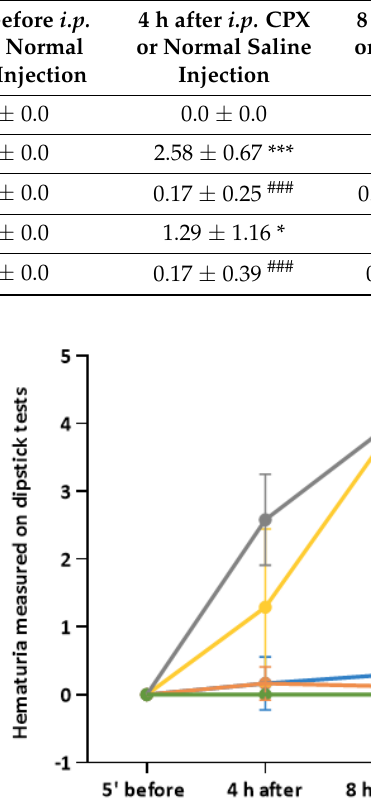
Figure 3. Hematuria measured semi-quantitatively on the dipstick test 5 min before, 4 h, 8 h, 24 h, and 48 h after injection of CPX in the studied groups or normal saline in the control group. Hematuria was evaluated from 0 to 4+ (0 means no hematuria detected and 4+ means macroscopically detectable hematuria). Data are presented as means ± SD. A detailed description of experimental groups is presented in Figure 1 and the Materials and Methods section, and detailed statistical comparisons are presented in Table 1. Table 1. Statistical comparisons of hematuria measured semi-quantitatively on the dipstick test between studied groups. Mean values of hematuria in the studied time points with corresponding SD are presented in Figure 4. A detailed descrip- tion of experimental groups is presented in Figure 1 and in the Materials and Methods section. * p < 0.05, *** p < 0.001 vs. CON group; ## p < 0.01, ### p < 0.001 vs. CPX group; ^ p < 0.05, ^^ p < 0.01, ^^^ p < 0.001 vs. CPX-C group.